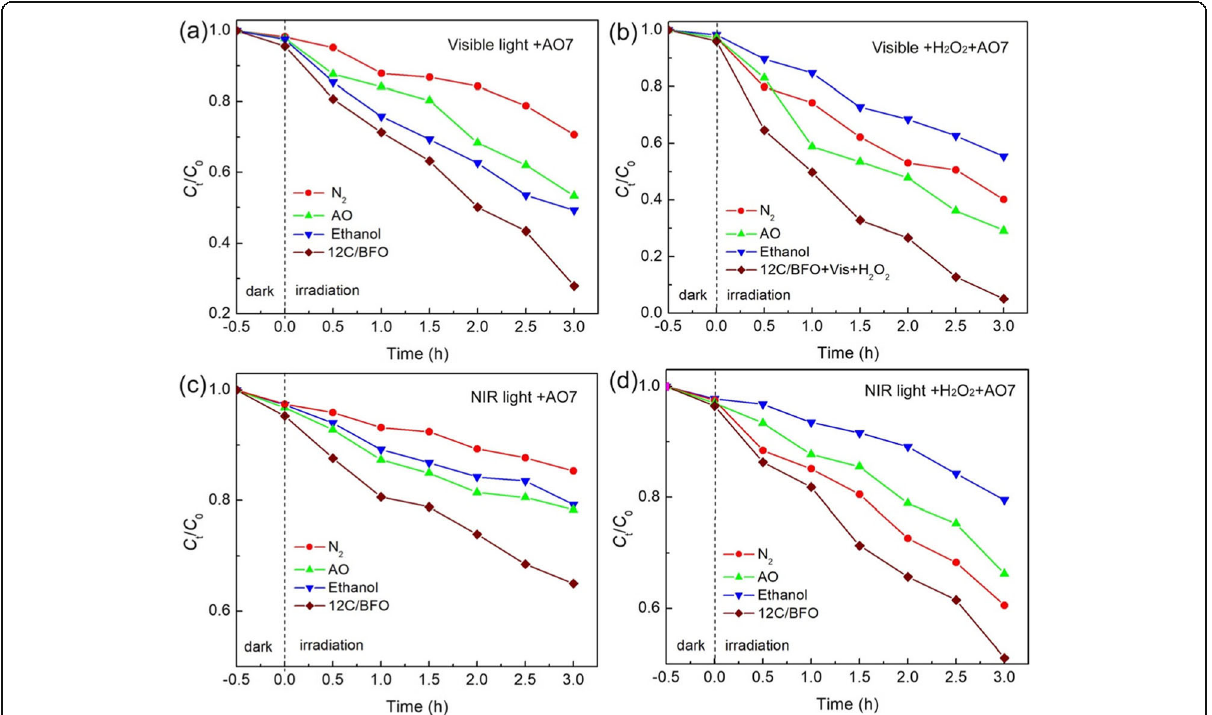
Fig. 10 a and b Effects of ethanol, N 2 purging, and AO on the photocatalytic and photo-Fenton catalytic degradation of AO7 over 12C/BFO under visible light irradiation, respectively. c and d Effects of ethanol, N 2 purging, and AO on the photocatalytic and photo-Fenton catalytic degradation of AO7 over 12C/BFO under NIR light irradiation,